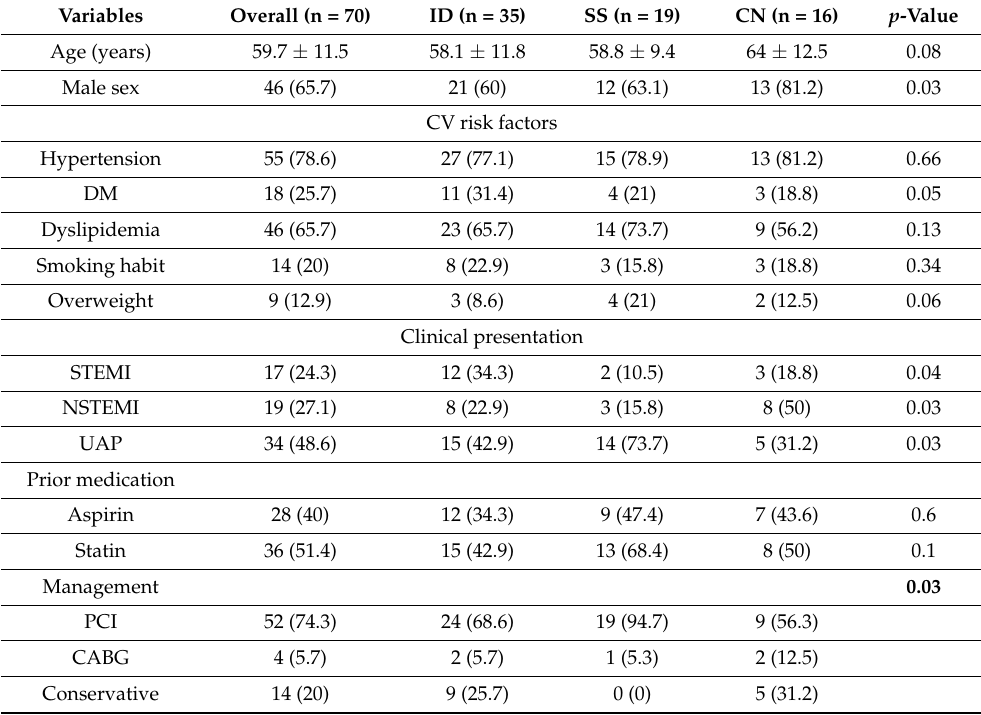
Table 2. Baseline patient characteristics.